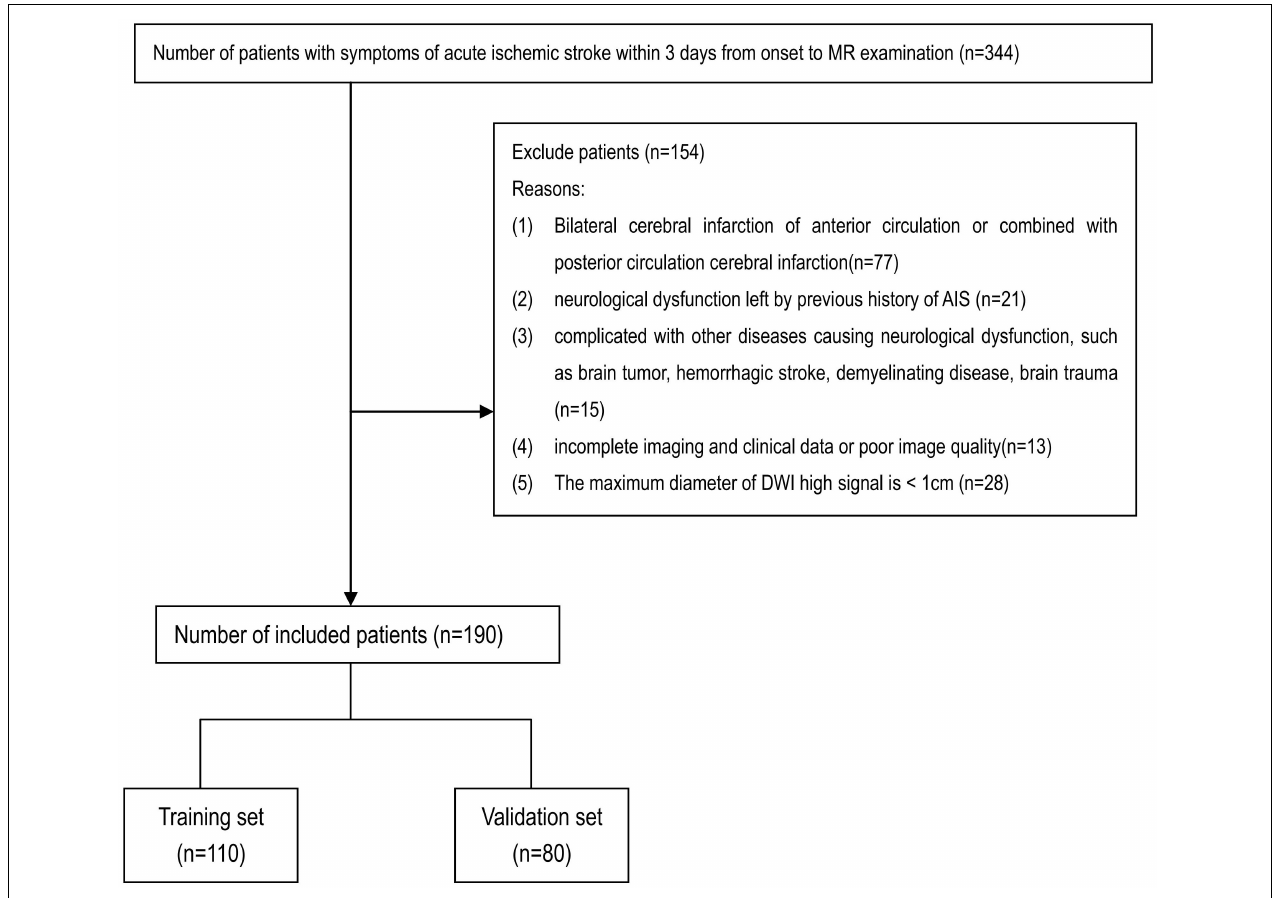
FIGURE 1 | Flowchart of the collection of